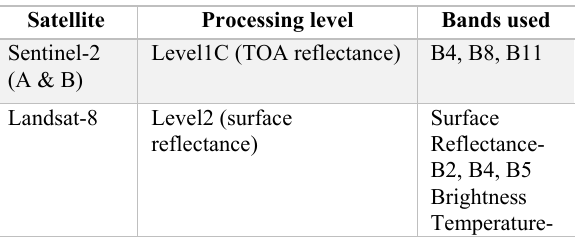
Satellite Processing